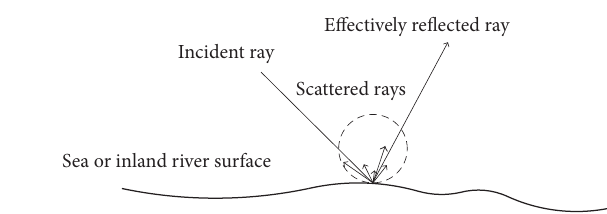
Figure 16: Scattering and effective